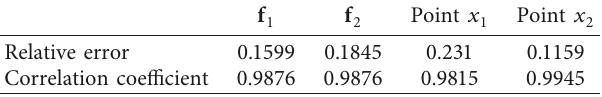
Figure 6: The optimization function value of F Table 1: The relative error and the correlation coefficient of the . identified F 1